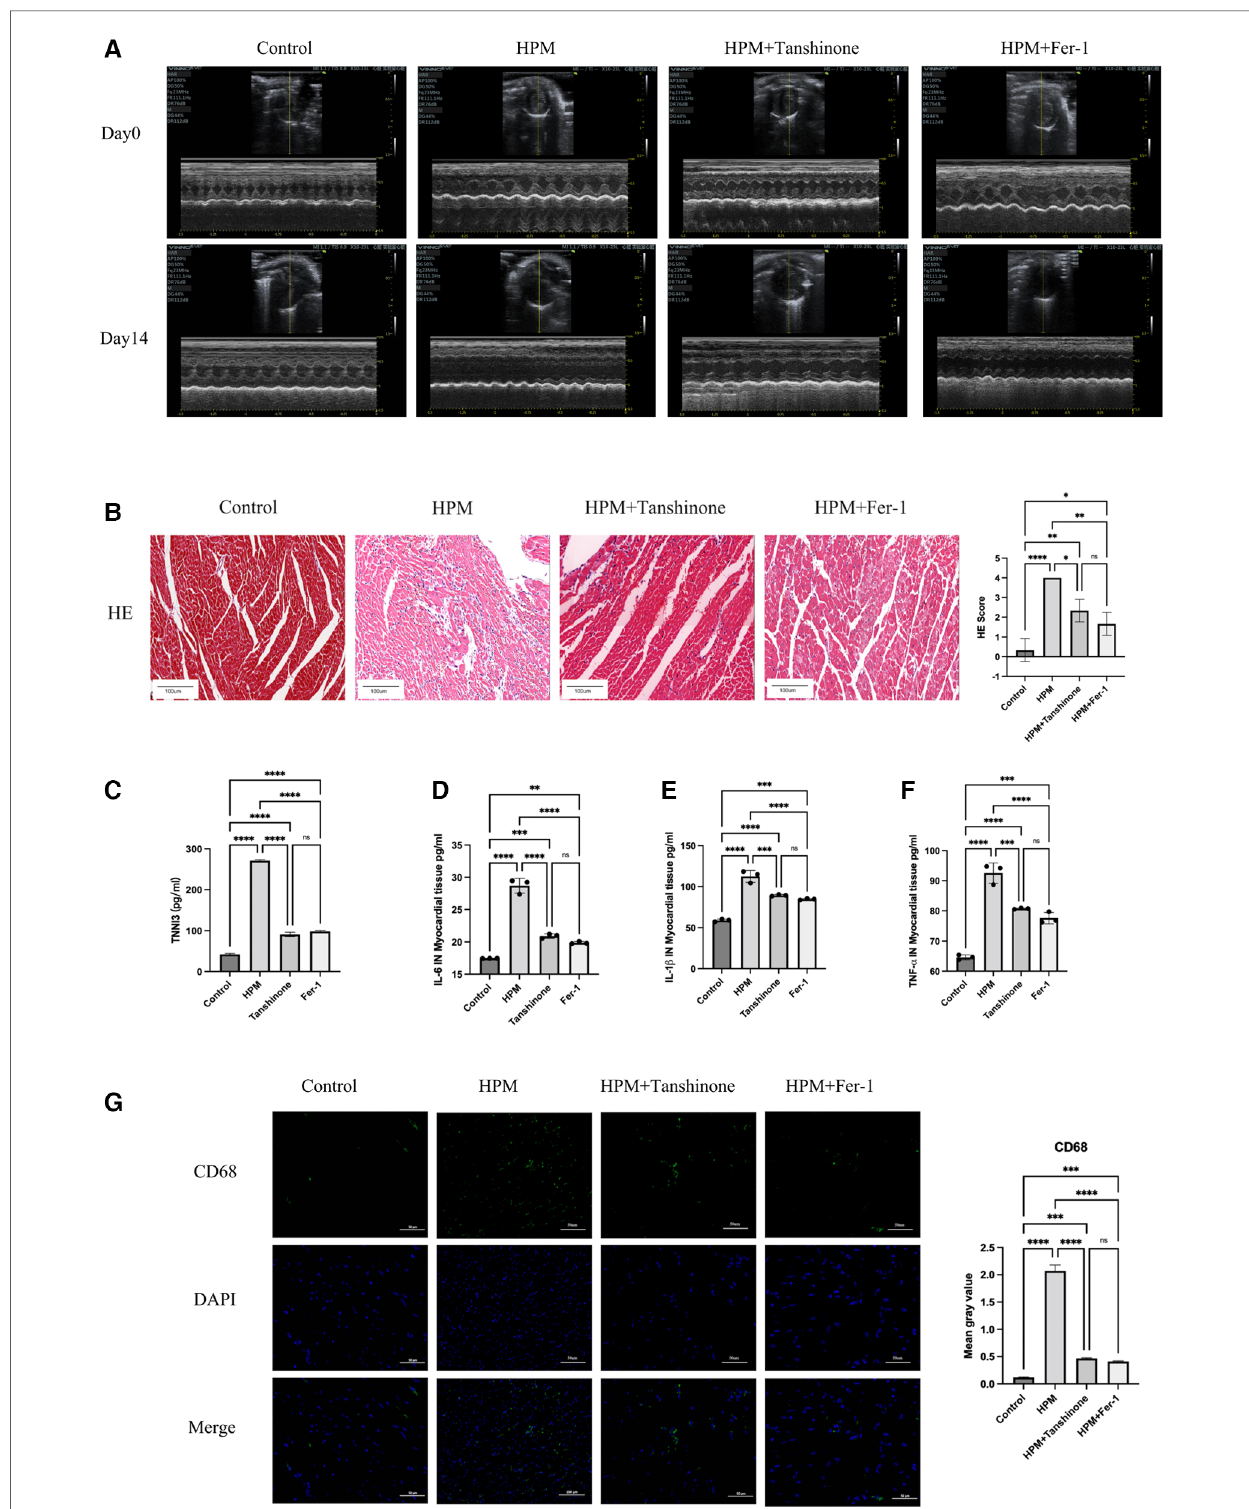
FIGURE 4 Tanshinone and Fer-1 inhibit in fl ammatory damage to myocardial tissue. ( A ) Echocardiography inControl, HPM 30 mW/cm 2 , Tanshinone and Fer-1 therapy group mice pre and after HPM. ( B ) HE staining in mouse myocardial tissue. Scale bar: 100 μ m. On the right, the number of in fl ammatory cells per mouse under the microscope is counted. Data presented are mean±SD of microscopic myocardial injury scores in 3 mice. *, P <0.05; **, P < 0.01;**** P <0.0001; ns, not signi fi cant, one-way ANOVA, post hoc comparisons, Tukey ’ s test. ( C )TNN3 concentration in mouse serum. ( D – F ) Elisa test the levels of IL-6, IL-1 β and TNF- α in myocardial tissue of mice. ( G ) Immuno fl uorescence technique staining of CD68, DAPI in myocardial section were conducted. Scale bar: 50 μ